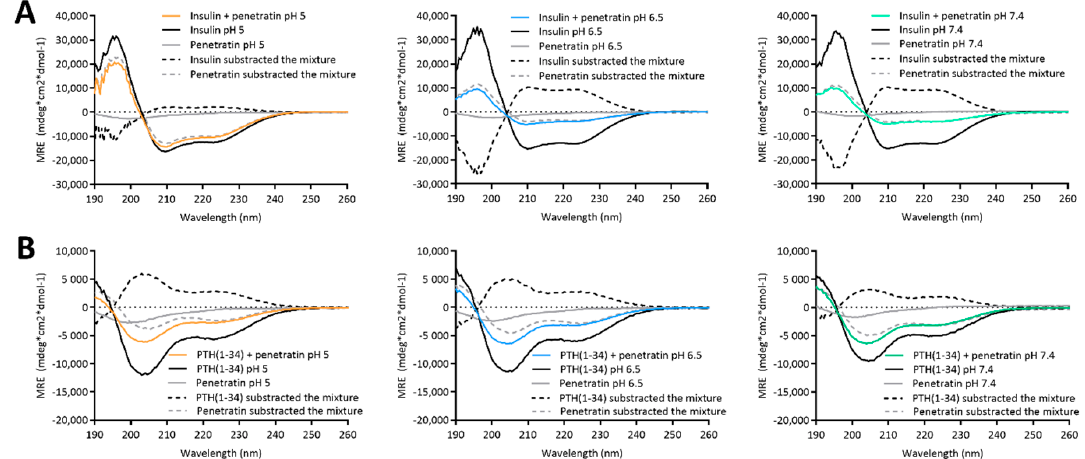
Figure 3. Circular dichroism spectra resulting from mixing 50 μ M insulin ( A ) or PTH(1 ‐ 34) ( B ) with 200 μ M penetratin at pH 5, 6.5, or 7.4. Dashed lines represent spectra resulting from subtracting the signal from samples containing only insulin/PTH(1 ‐ 34) or penetratin from the signal originating from samples containing insulin or PTH(1 ‐ 34) in mixture with penetratin.